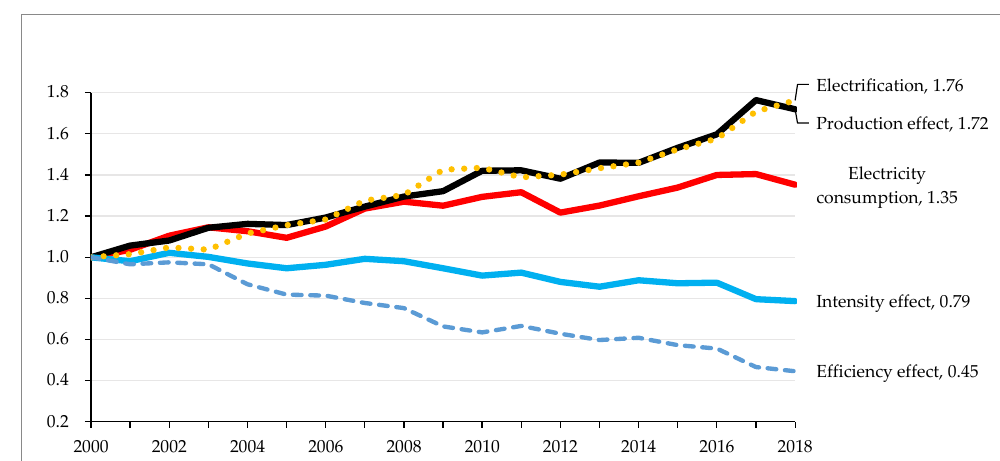
Figure A4. Petrochemical electricity consumption LMDI results (fixed base year, multiplicative).